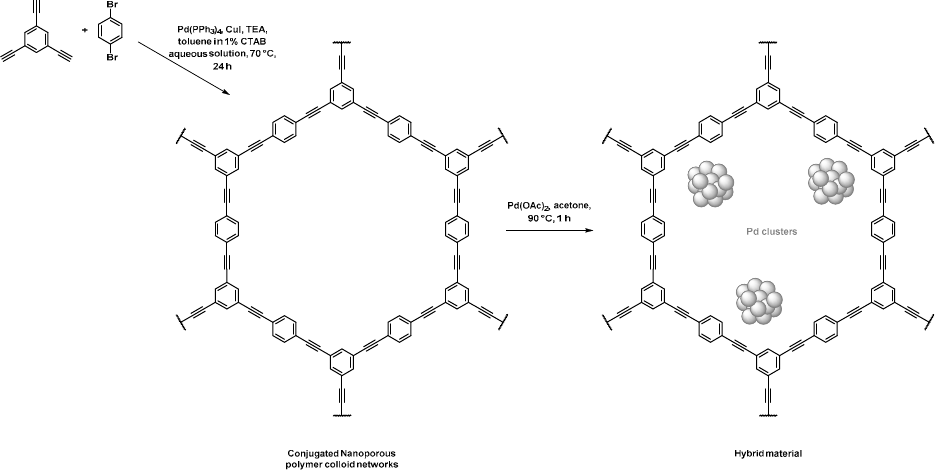
Figure 1. Synthetic path used for the synthesis of porous conjugated organic scaffolds by Sonogashira coupling and their use as support for the adsorption of Pd NPs [41].